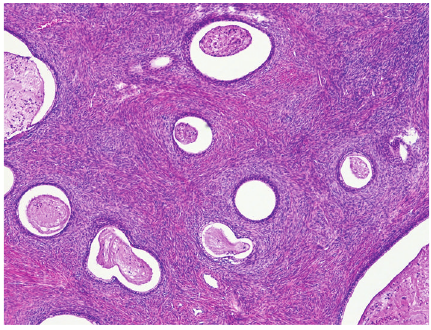
Figure 3: Relatively uniform mucinous glands are associated with a prominent fibrous stroma ( × 40, H&E stain).